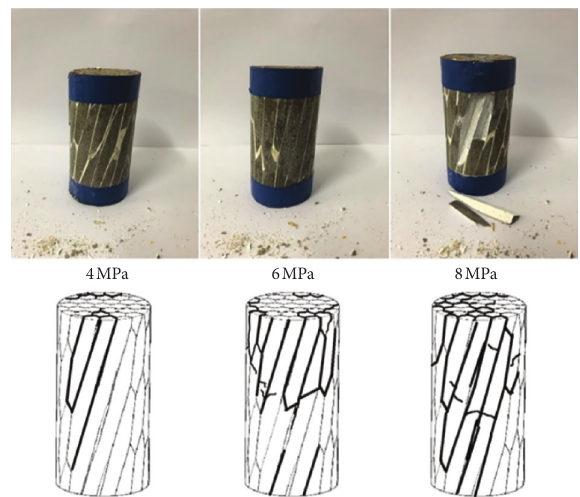
Figure 6: Failure modes under different initial confining